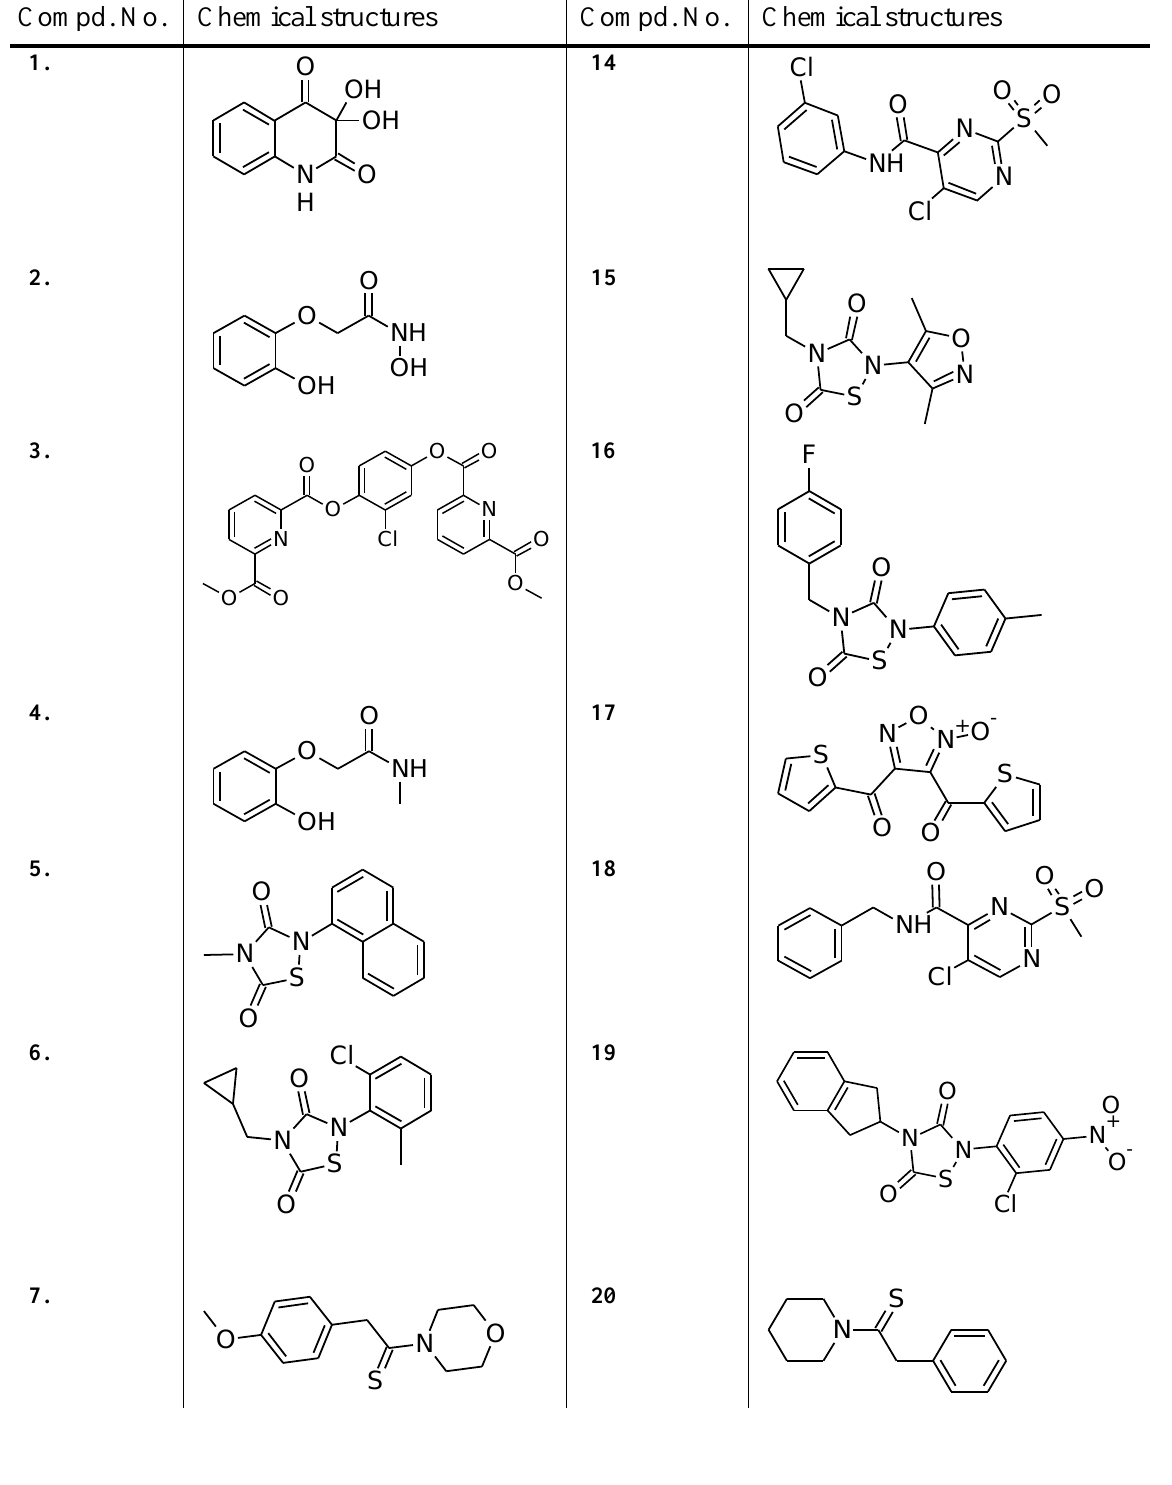
Table S1. Chemical structures of Mycobacterium tuberculosis AlaR inhibitors 1-25 . Compd.